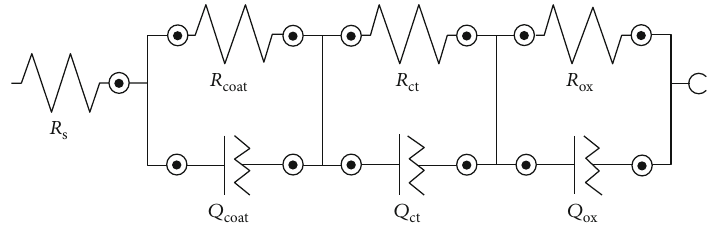
-LDH-enriched primer. x